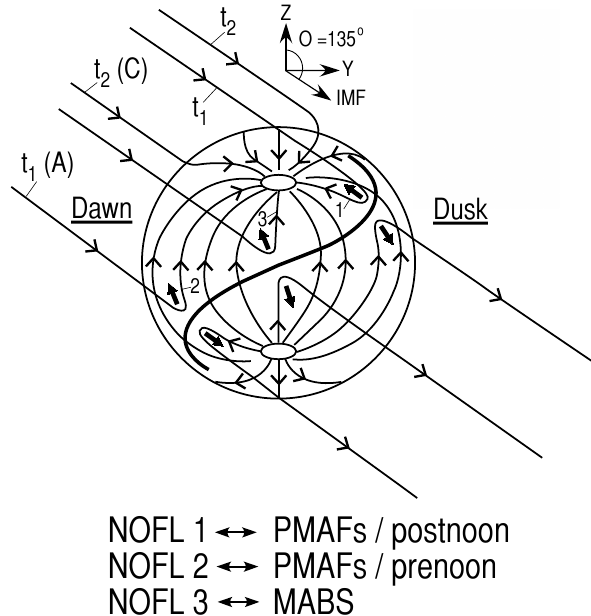
Fig. 17. Schematic view of solar wind-magnetosphere interconnec- tion topology for a southeast directed IMF. The view is from the Sun. North is up and the dawn side to the left. S-shaped recon- nection X-line and the magnetic tension force on newly open field lines are indicated in the postnoon (1), prenoon (2) and subsolar (3) regions. Newly open ( t 1 ) and old open ( t 2 ) field lines are marked in the Northern Hemisphere. Insert in upper right corner shows the IMF direction ( θ =135 ◦ ) in GSM Y-Z